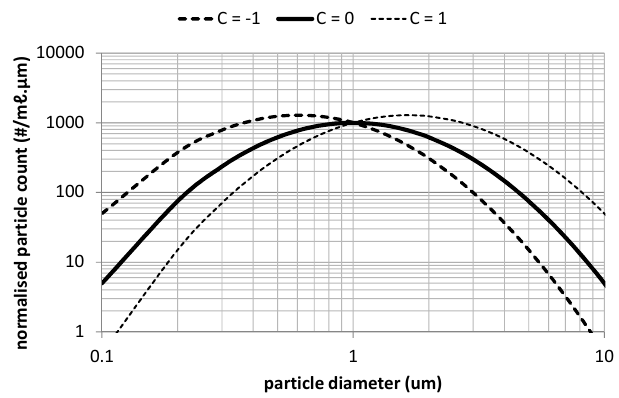
Figure 8. The e ff ect of model parameter C on the particle size dis- tribution, with A = 1000 and β = − 1.